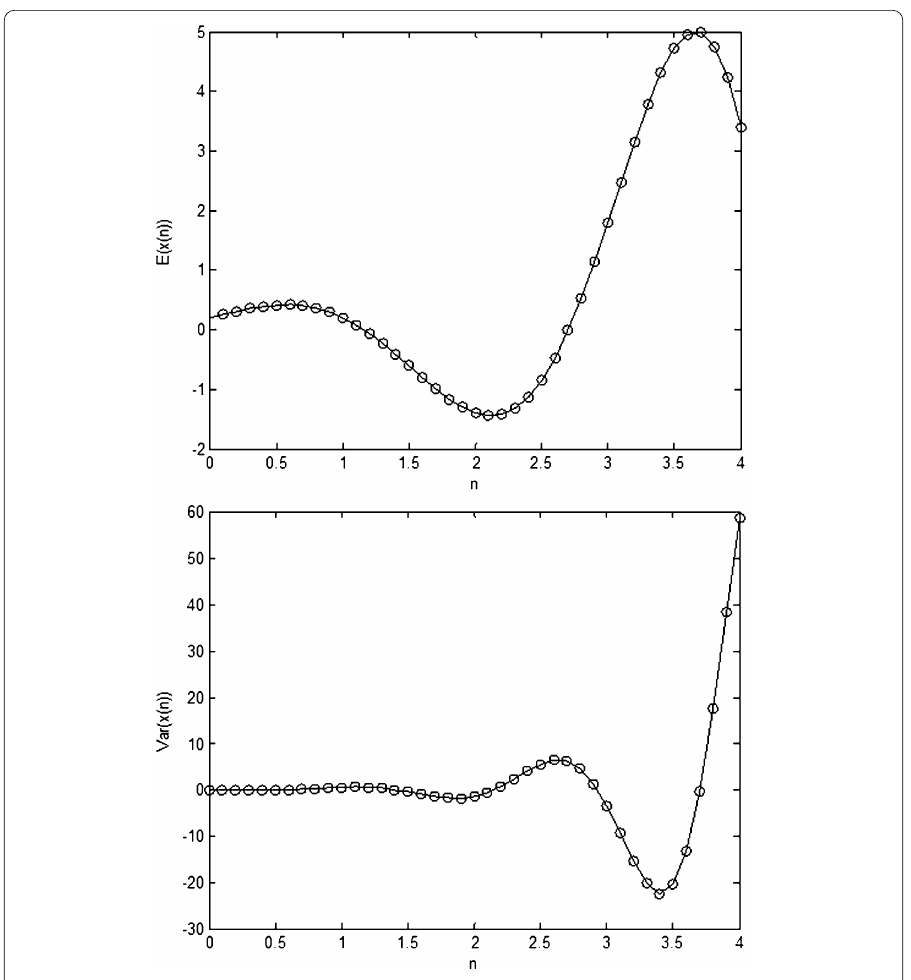
Figure 4 Expected value and variance obtained from the Z-transform of